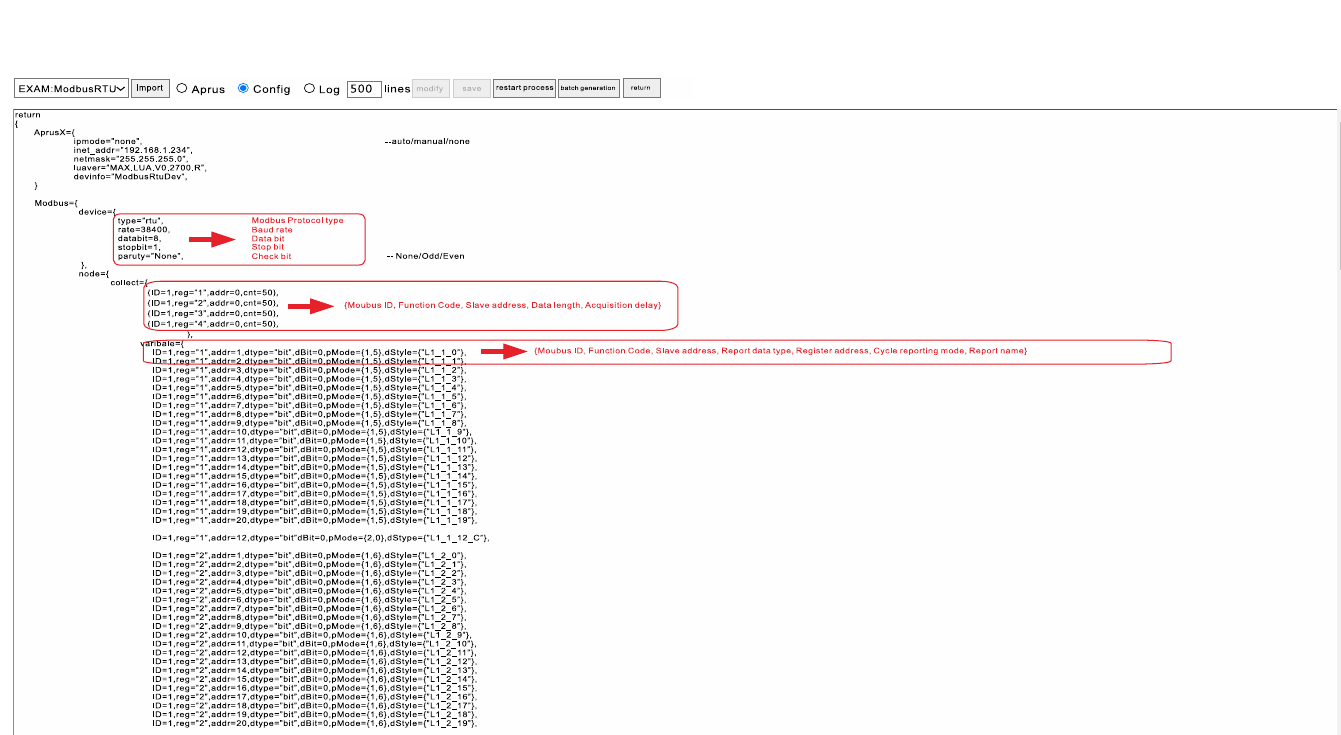
Fig 2. APRUS adapter.